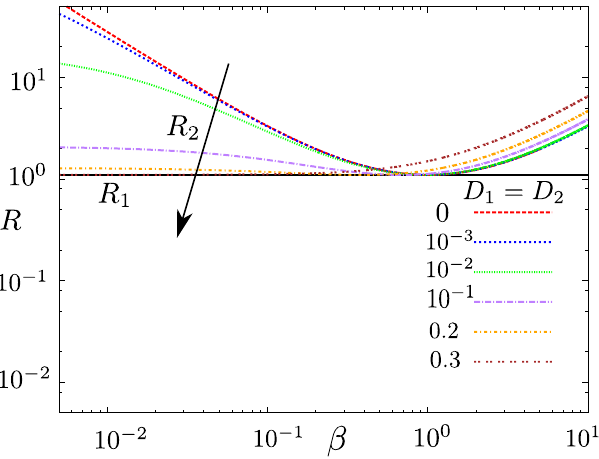
10. R - β stability diagram including polar contributions l and γ a to flow alignment and active stress. The line at R ¼ R 1 denoting the junction between the O ð q Þ and the O ð q 2 Þ instabilities remains unchanged. However, the line R ¼ R 2 , which marks the borderline between the O ð q 2 Þ instability and the stable aligned state, starts to deviate as the active capillary numbers decrease from very large values toward values of the order of